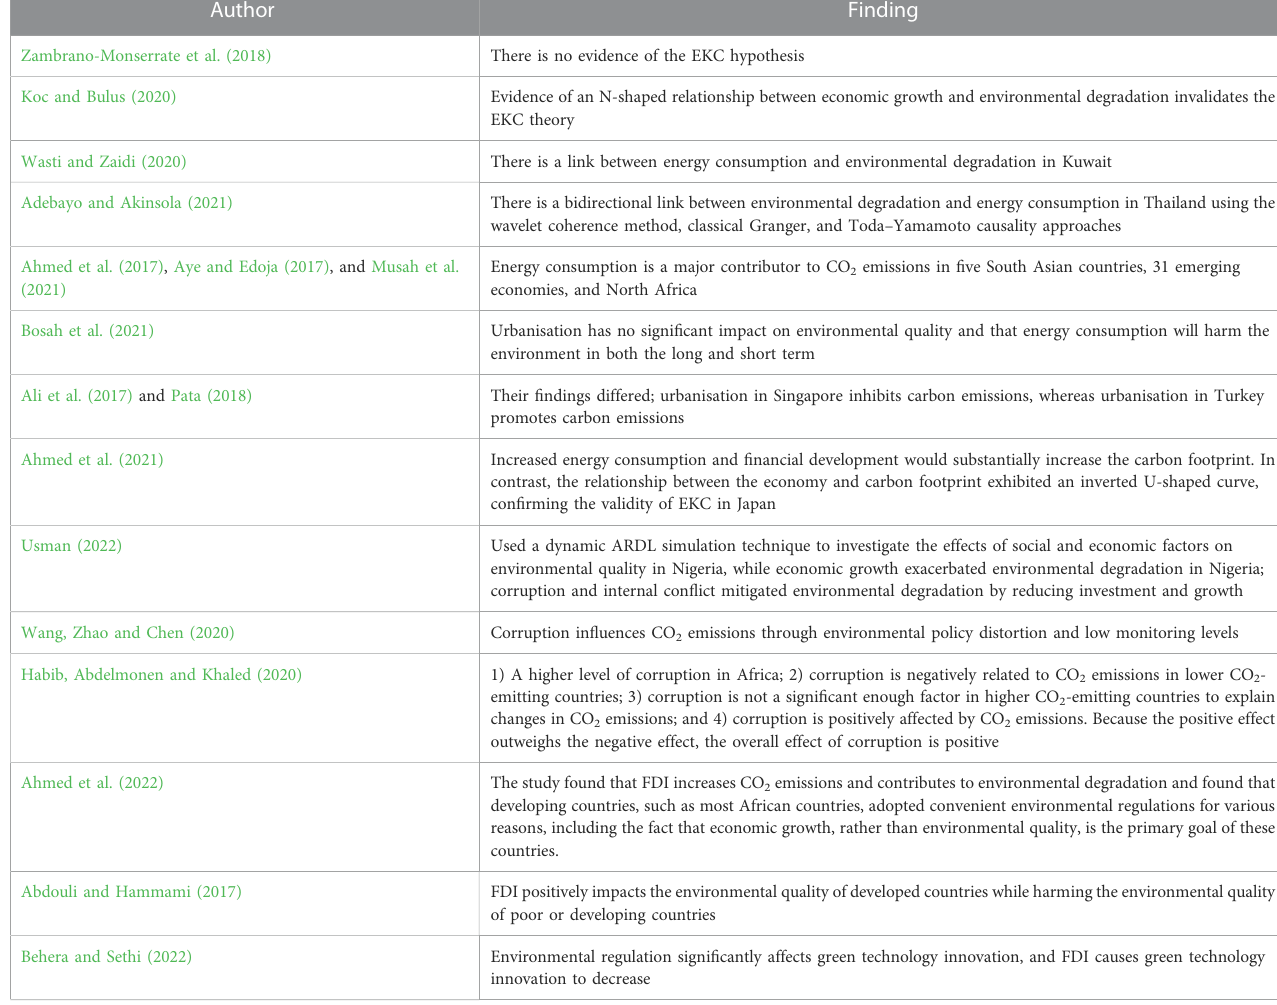
TABLE 1 Summary of the literature